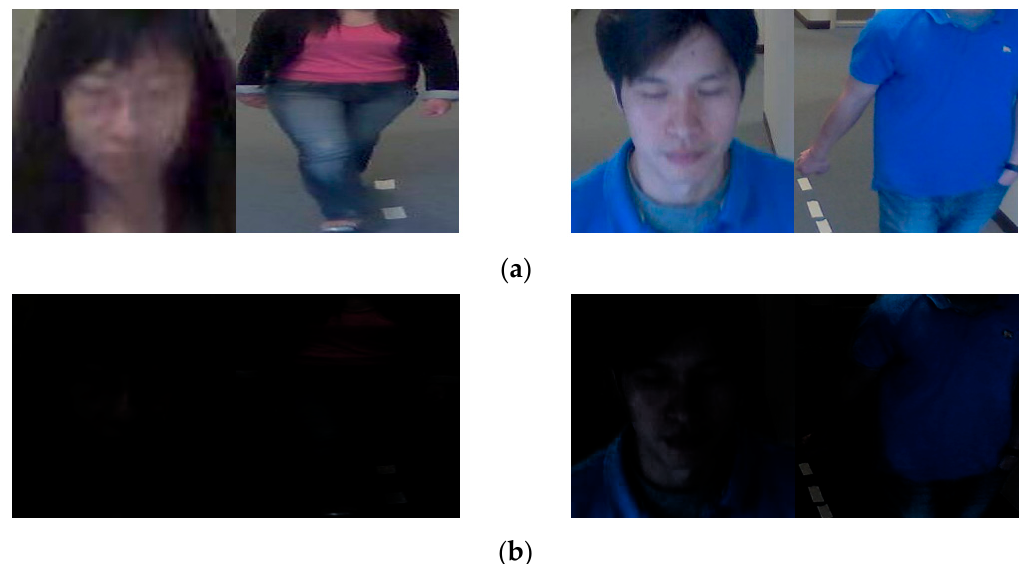
Figure 4. Example images for ChokePoint dataset. ( a ) Original images of ChokePoint dataset [34]. ( b ) Converted low- illumination image of ChokePoint dataset. Table 5. Overall images of ChokePoint dataset and